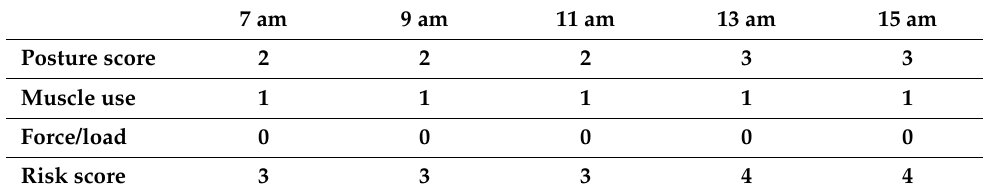
Table 4. Average score points are assessed when worker is wearing the